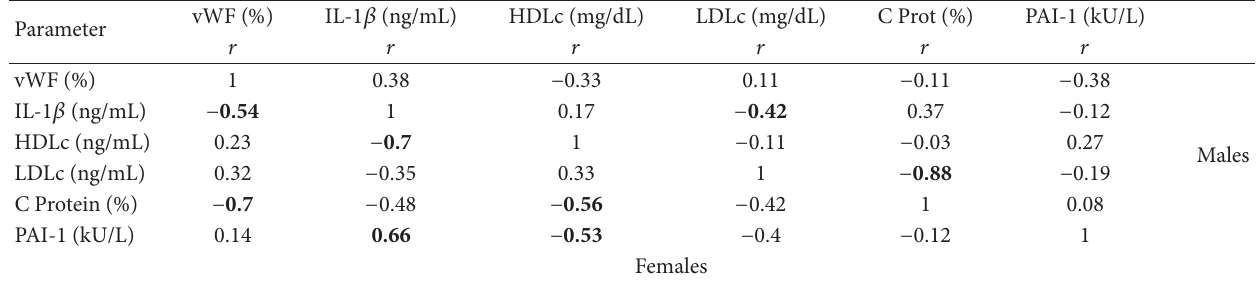
T 3: e mean values of monitored parameters in the studied groups.